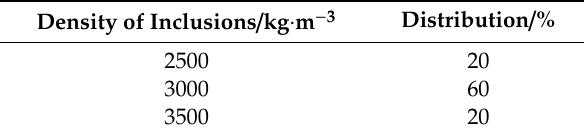
Table 5. Densities of simulated inclusions and their distribution in the total volume of inclusions.